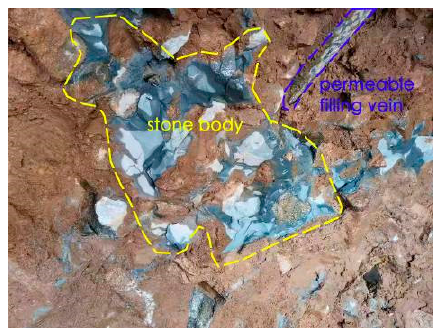
Figure 13. Slurry diffusion in the sidewall.